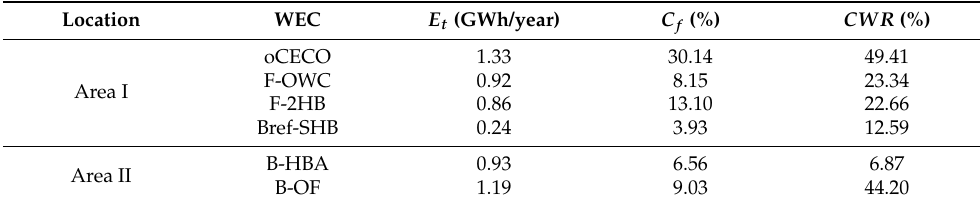
Table 6. Performance assessment of the optimised